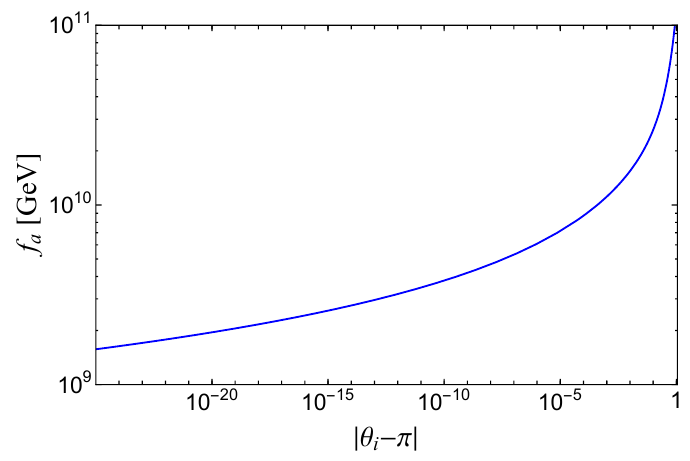
Figure 1 . The relation between f a and j (cid:18) i (cid:0) (cid:25) j explaining the DM abundance (cid:10) a h 2 = 0 : 12